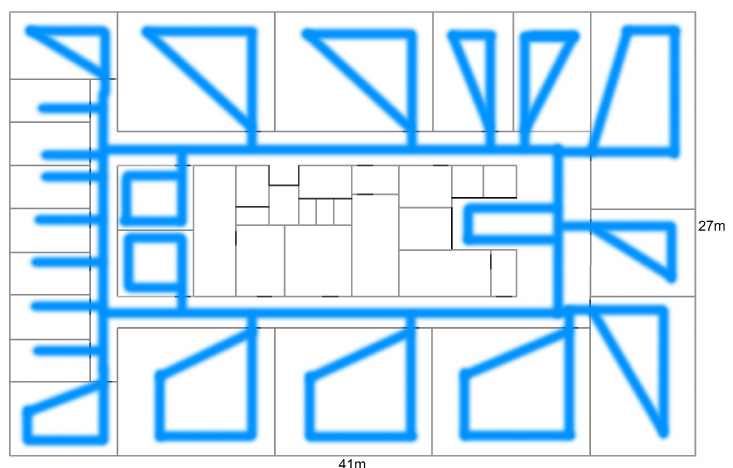
Figure 7. Floor plan with rough indication of the training